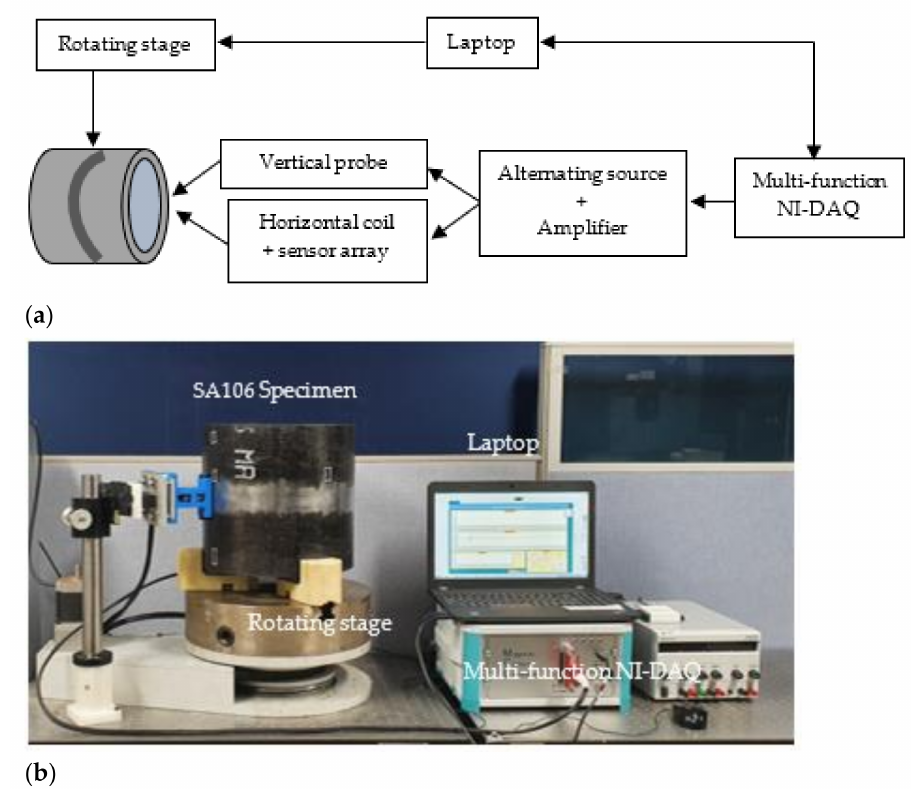
Figure 1. Experimental setup. ( a ) Bloc diagram of ECT equipment and ( b ) inspection